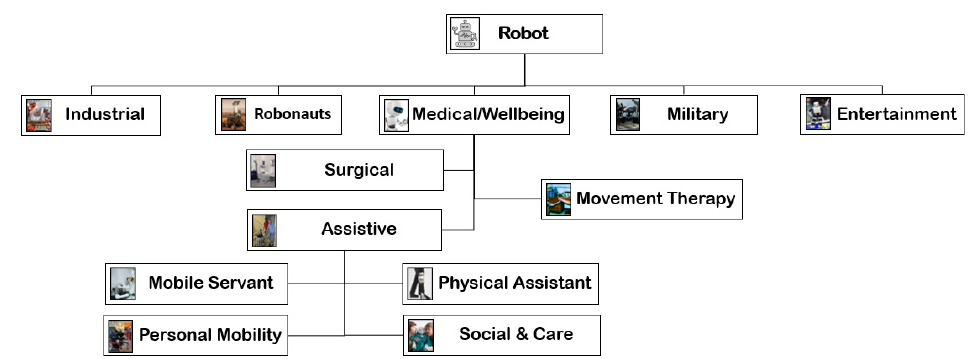
Figure 1. Different Types of Robotic Systems .